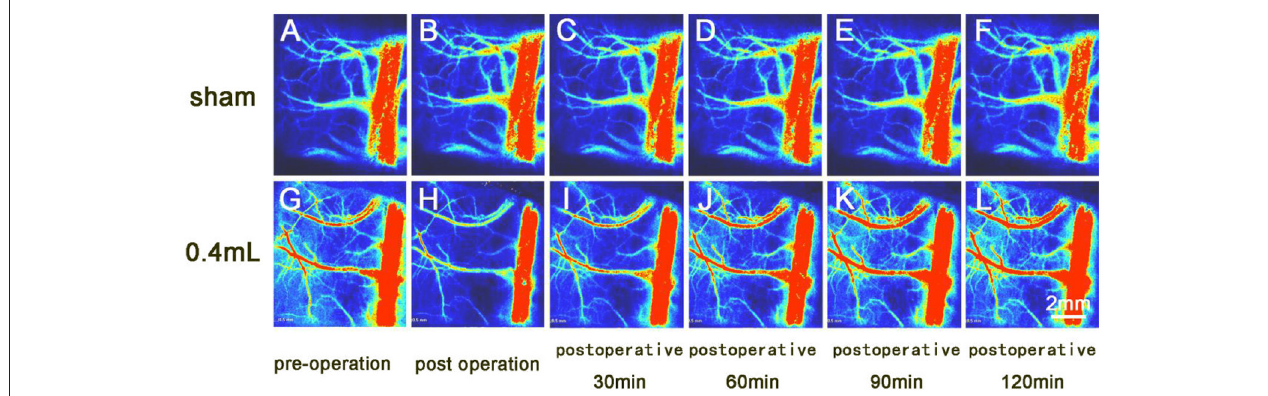
FIGURE 3 | Laser speckle imaging of arterial and venous blood flow on the side opposite the hematoma. (A–F) The cerebral surface blood flow of the sham group was essentially unchanged over the 120-min observation period. (G–L) The cerebral surface blood flow of the 0.4ml group decreased after hematoma injection, and the veins and arteries gradually recovered by 90min after surgery, while the superior sagittal sinus did not recover its preoperative blood